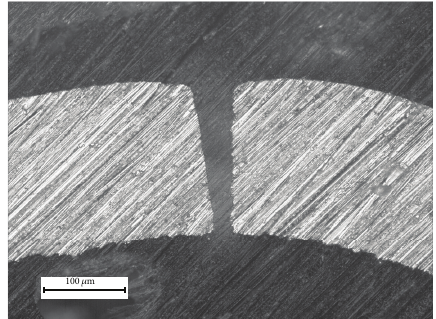
Figure 8: Cross-section of a linear incision produced using Ar as the assist gas, after chemical